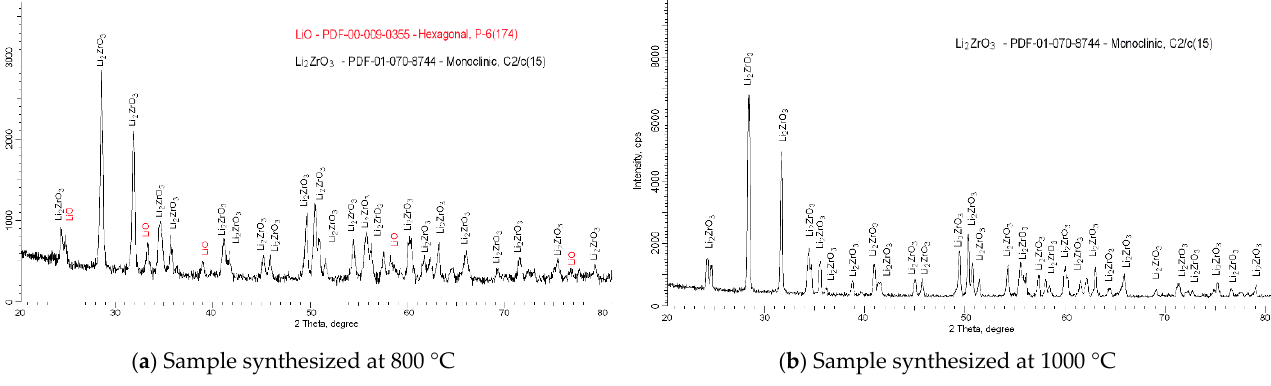
Figure 2. Results of X-ray phase analysis of the studied samples.